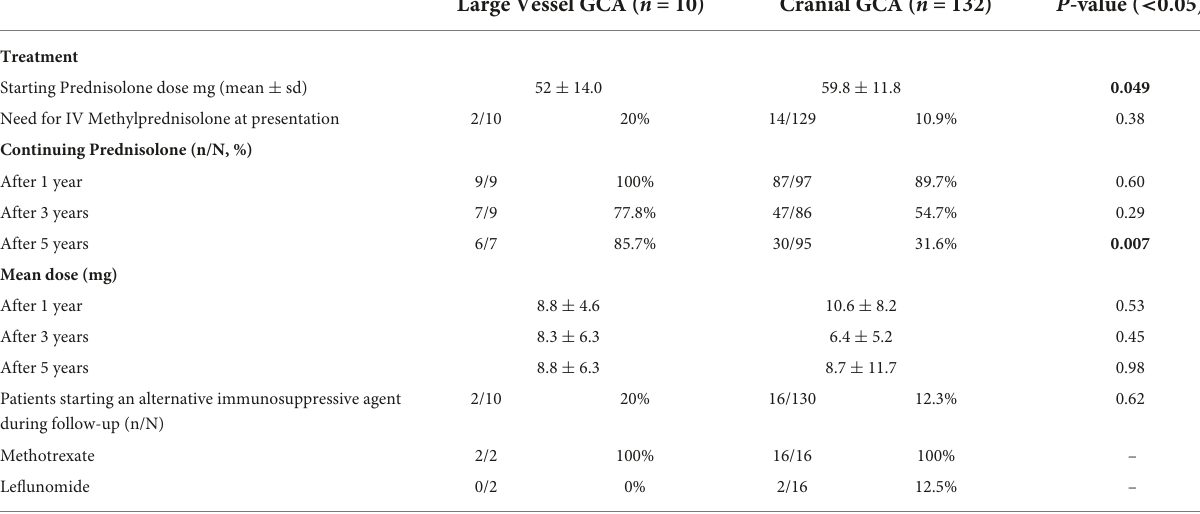
TABLE 2 Comparison of treatment variables in patients with large vessel giant cell arteritis (GCA) and cranial GCA. Large Vessel GCA ( n = 10) Cranial GCA ( n = 132) P -value ( <